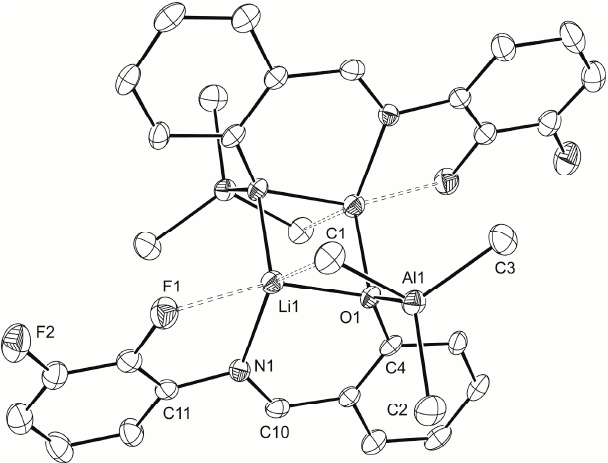
Figure 1. ORTEP plots for 1 showing thermal ellipsoids plots (30% probability). Hydrogen atoms are omitted for clarity. Selected bond distances (Å) and angles (°): C(1)-Al(1) 1.994(5), C(2)-Al(1) 1.953(6), C(3)-Al(1) 1.954(5), O(1)-Al(1) 1.902(3), C(1)···Li(1) 2.413(4), C(10)-N(1) 1.280(6), Li(1)-O(1) 1.982(8),